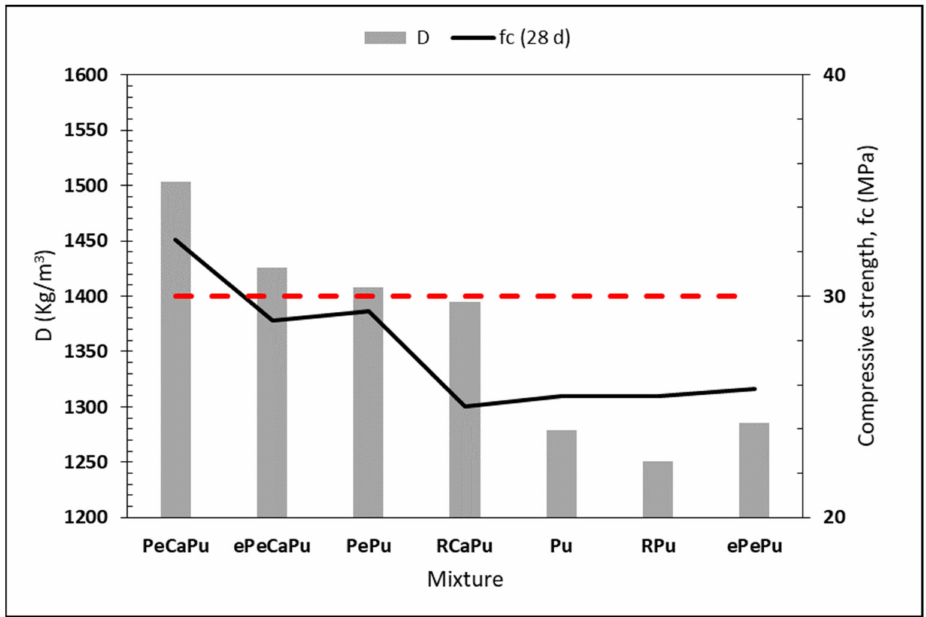
Figure 2. Characteristic compressive strength (f c ) at the age of 28 days with respect to the density of LWC